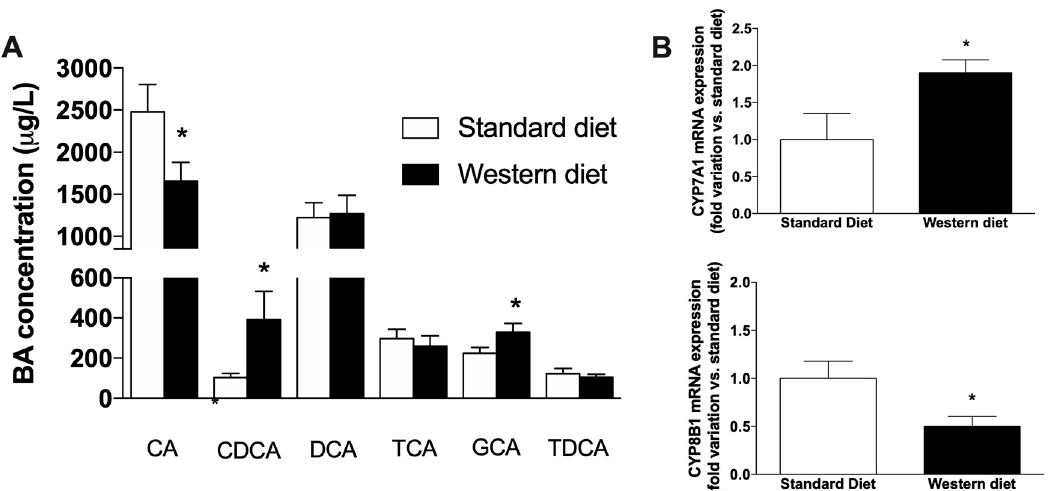
Figure 6. Analysis of plasma bile acids. ( A ) Alteration of circulating BAs induced by the administration of a Western diet. ( B ) Hepatic mRNA expression of genes involved in BA synthesis. * p < 0.05 vs. rats fed with standard diet.